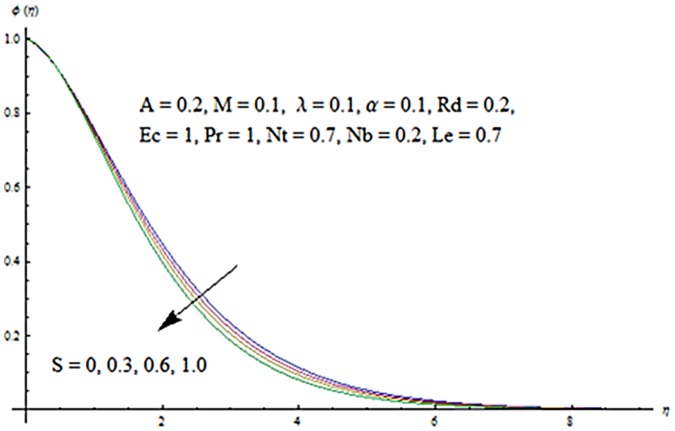
Influence of S on ϕ.